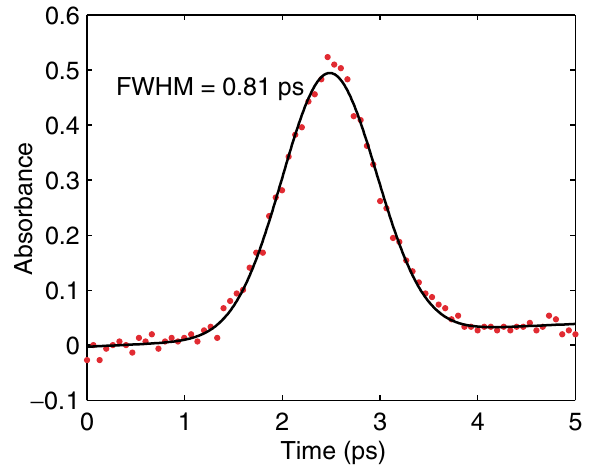
FIG. 13. (Color) Pulse length measurement of the HGHG out- put using two-photon absorption pump-probe autocorrelation for a seed power of 30 MW.